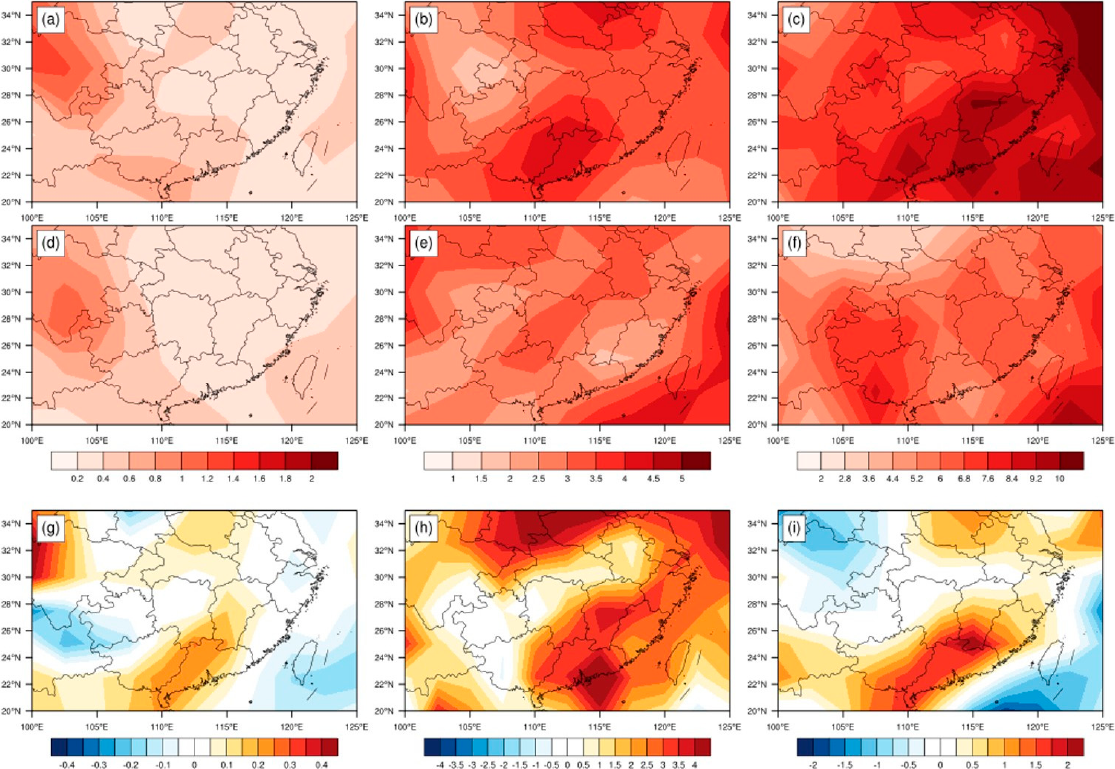
Figure 6. Standard deviations of vertically integrated moisture flux divergence from 1000 to 500 hPa (( a , d , g ); unit:10 - 6 kg m - 2 s - 1 ), vertically integrated omega from 850 to 500 hPa (( b , e , h ); unit: kg (m · s) - 3 ), OLR (( c , f , i ); unit: W m - 2 ) in S1 ( a – c ); and S2 ( d – f ) and the respective difference